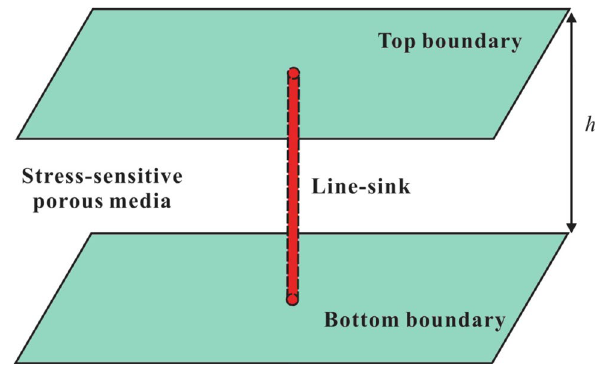
Fig. 1 A line-sink of natural gas in stress-sensitive porous